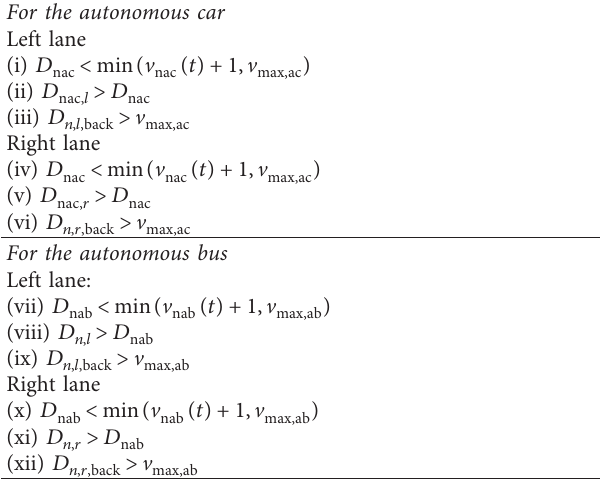
Table 5: Polite lane change